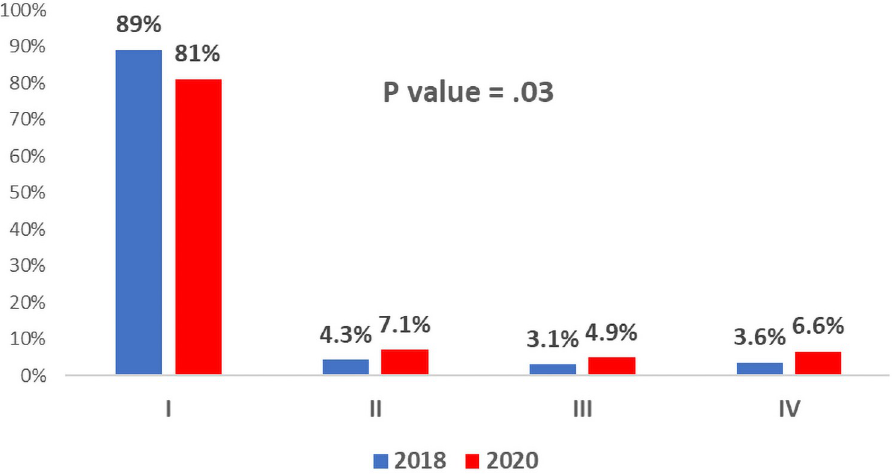
Fig 4. Distribution of STEMI patients according to Killip class at hospital admission before and during the Covid- 19 pandemic. Red bars represent patients admitted with STEMI during the first wave of Covid-19 in 2020 and blue bars represent patients admitted with STEMI during the corresponding control period in